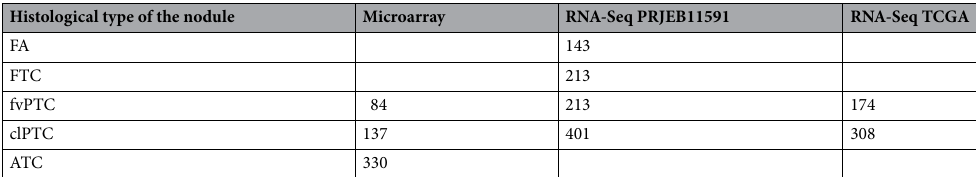
Table 1. Numbers of lncRNAs differentially expressed in thyroid nodules compared to normal thyroid tissue. FA follicular adenoma, FTC follicular thyroid carcinoma, fvPTC follicular variant of papillary thyroid carcinoma, clPTC classical variant of papillary thyroid carcinoma, ATC anaplastic